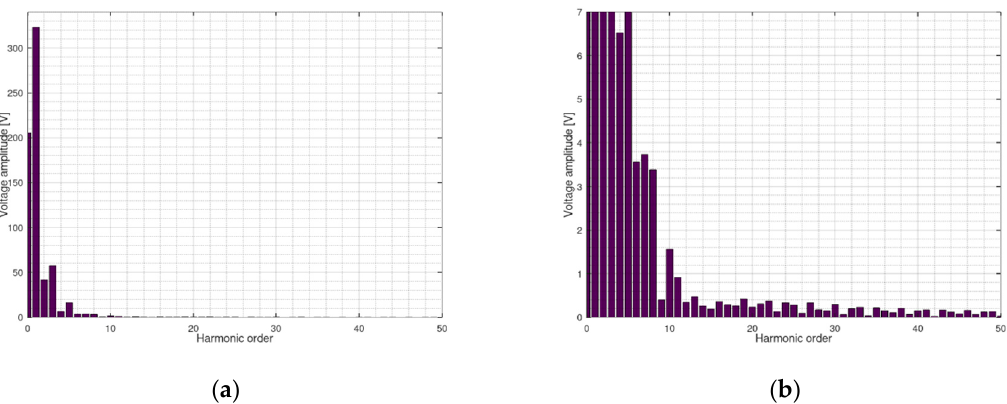
Figure 8. Harmonic spectrum of the voltage across the nonlinear element: ( a ) for the first 50 harmonic orders; ( b ) detailed view of ( a ).